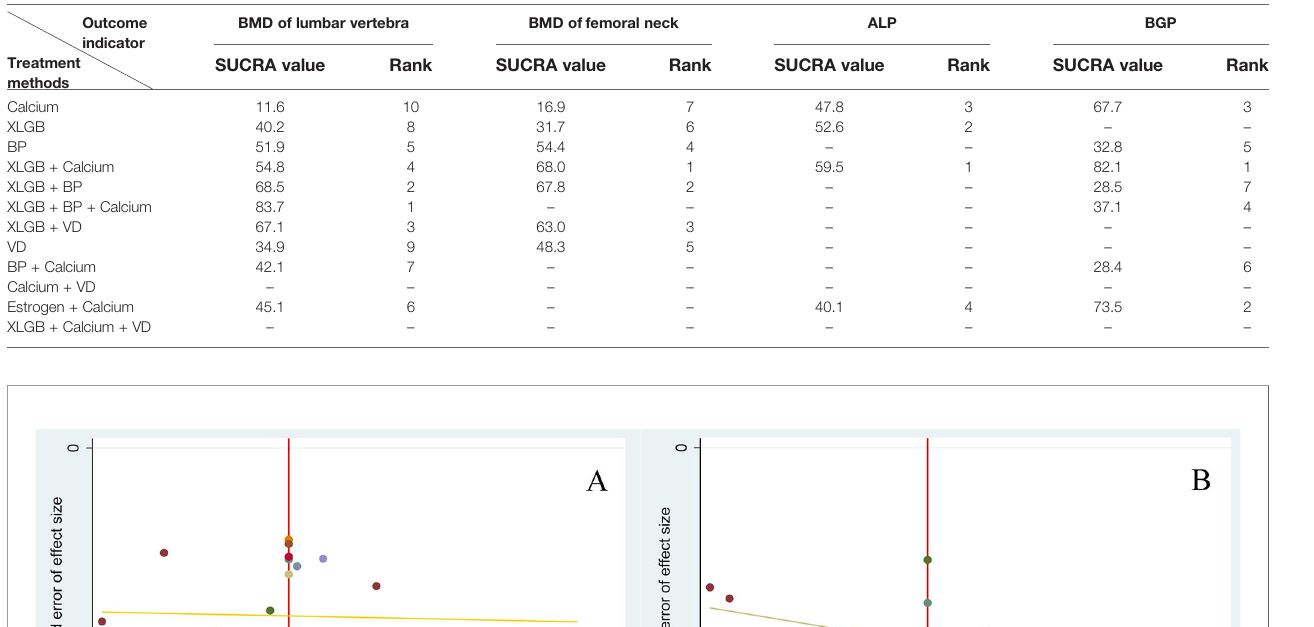
TABLE 11 | Rank of ef fi cacy of included treatments.